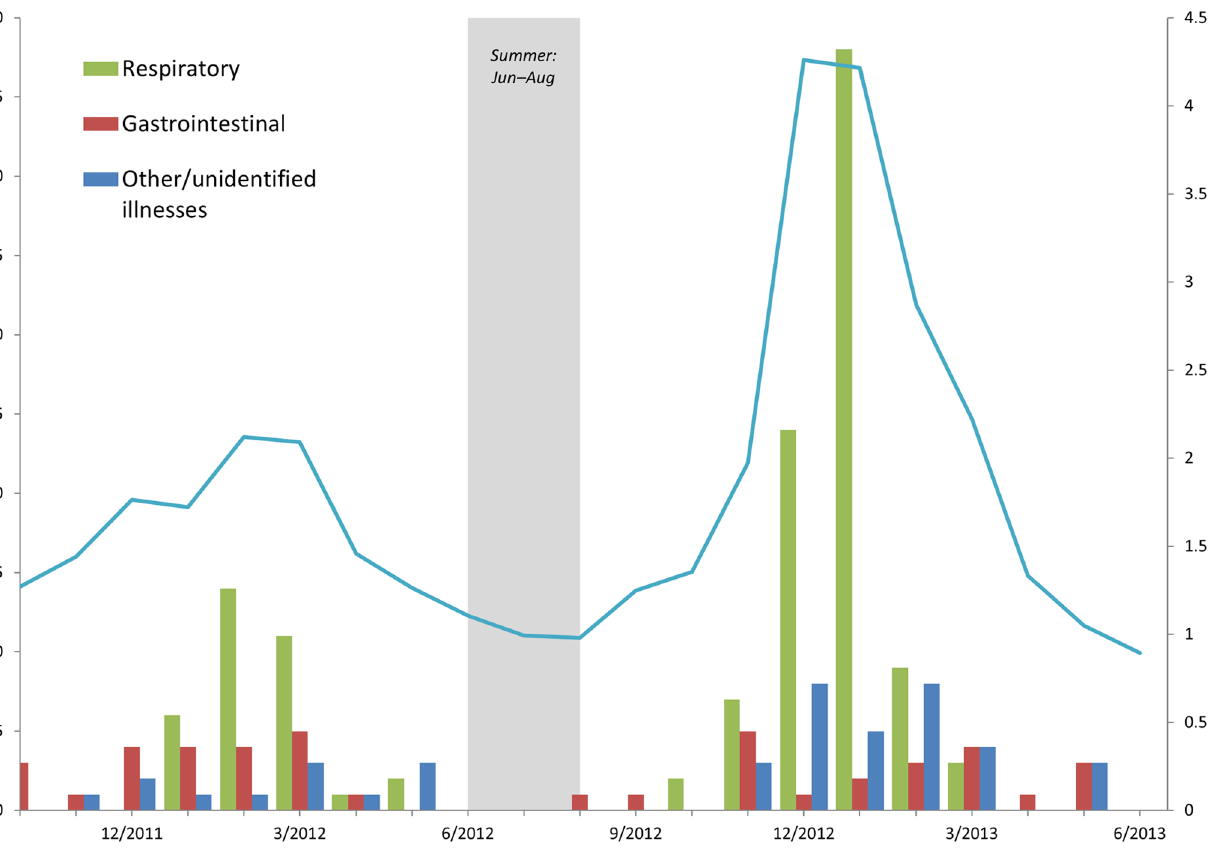
Figure 2. Number of illness-related school closure events by week and type of illness and national percent of medical provider visits for influenza- like illness — United States, 2011–2013. *National percent of medical provider visits for influenza-like illness [15].